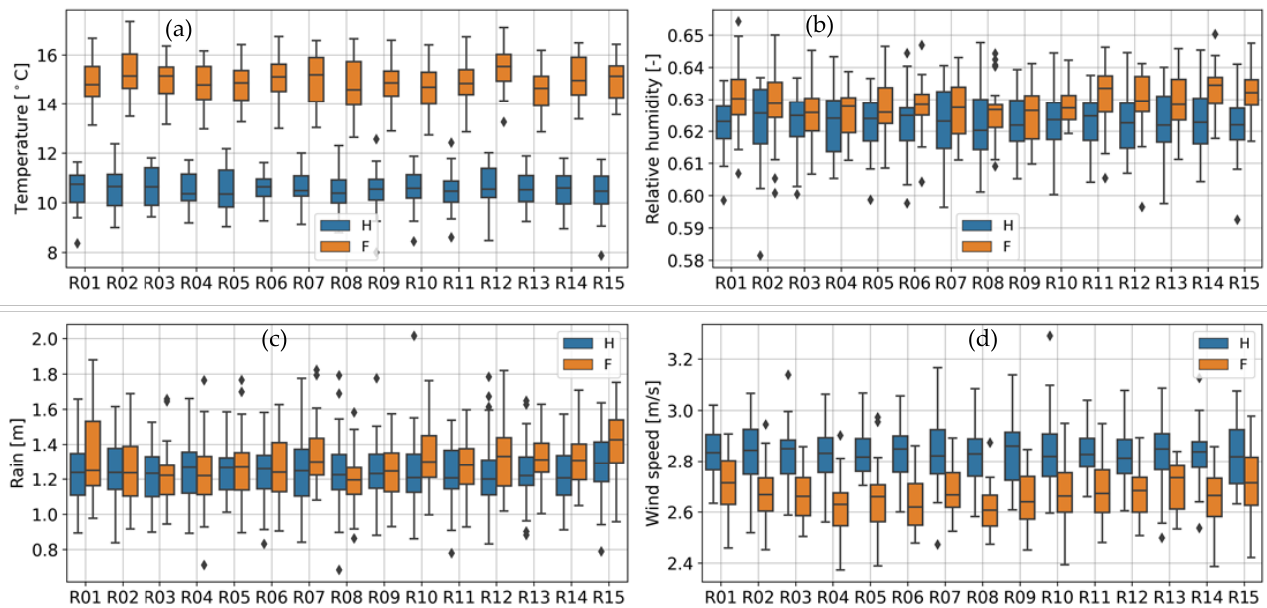
Figure 2. Boxplots of the annual average temperature ( a ), relative humidity ( b ) and wind speed ( d ), and annual sum of horizontal rain ( c ) for the 15 runs of historical (H) and future (F) time-periods in the city of Vancouver.